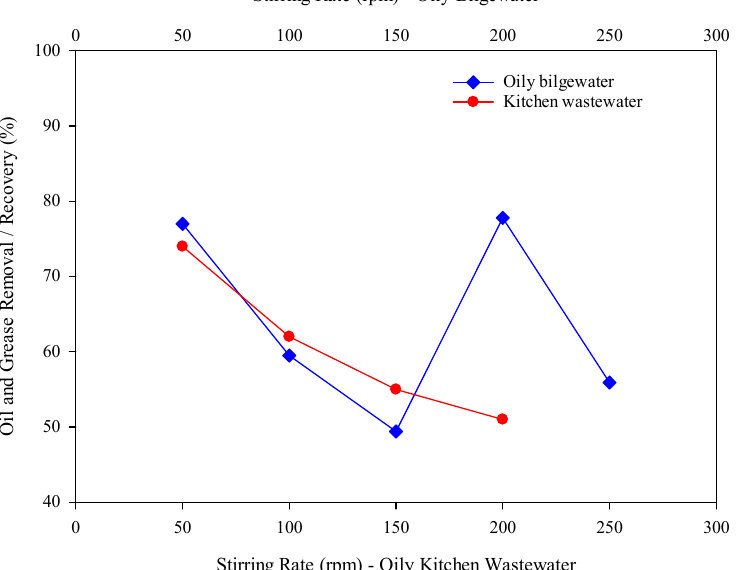
Figure 6. Changes of oil and grease removal/recovery for oily bilgewater and kitchen wastewater samples at different stirring rates (rpm).